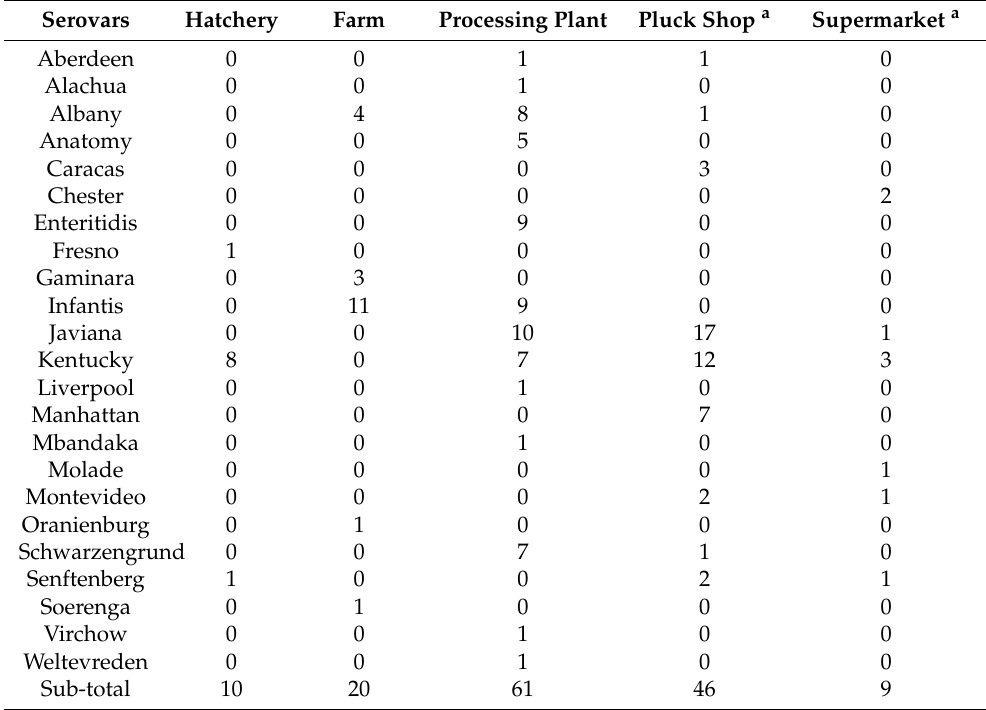
Table 1. The distribution of serovars of Salmonella isolates from various sources based on in silico